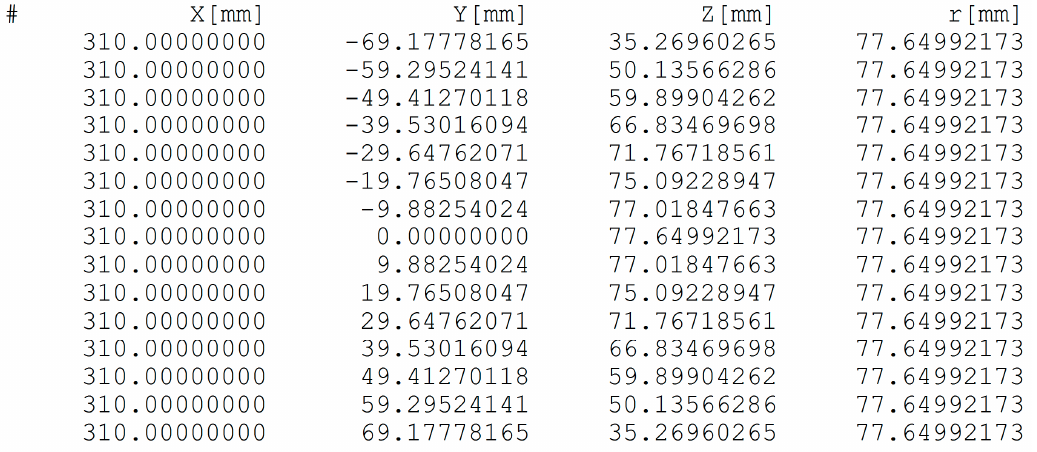
Figure 6. A list of coordinates of the spots at the screen generated by the software (additionally values of √𝑌 (cid:2870) (cid:3397) 𝑍 (cid:2870) are displayed).